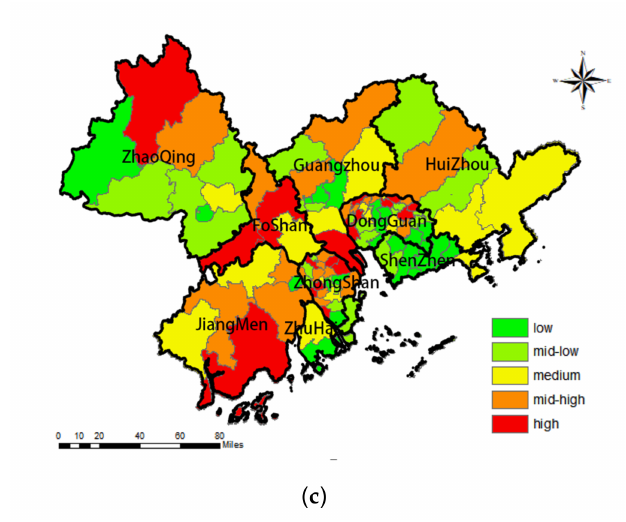
Figure 8. HVRs at district scale in the PRD. ( a ) 2013, ( b ) 2016, ( c ) 2019.